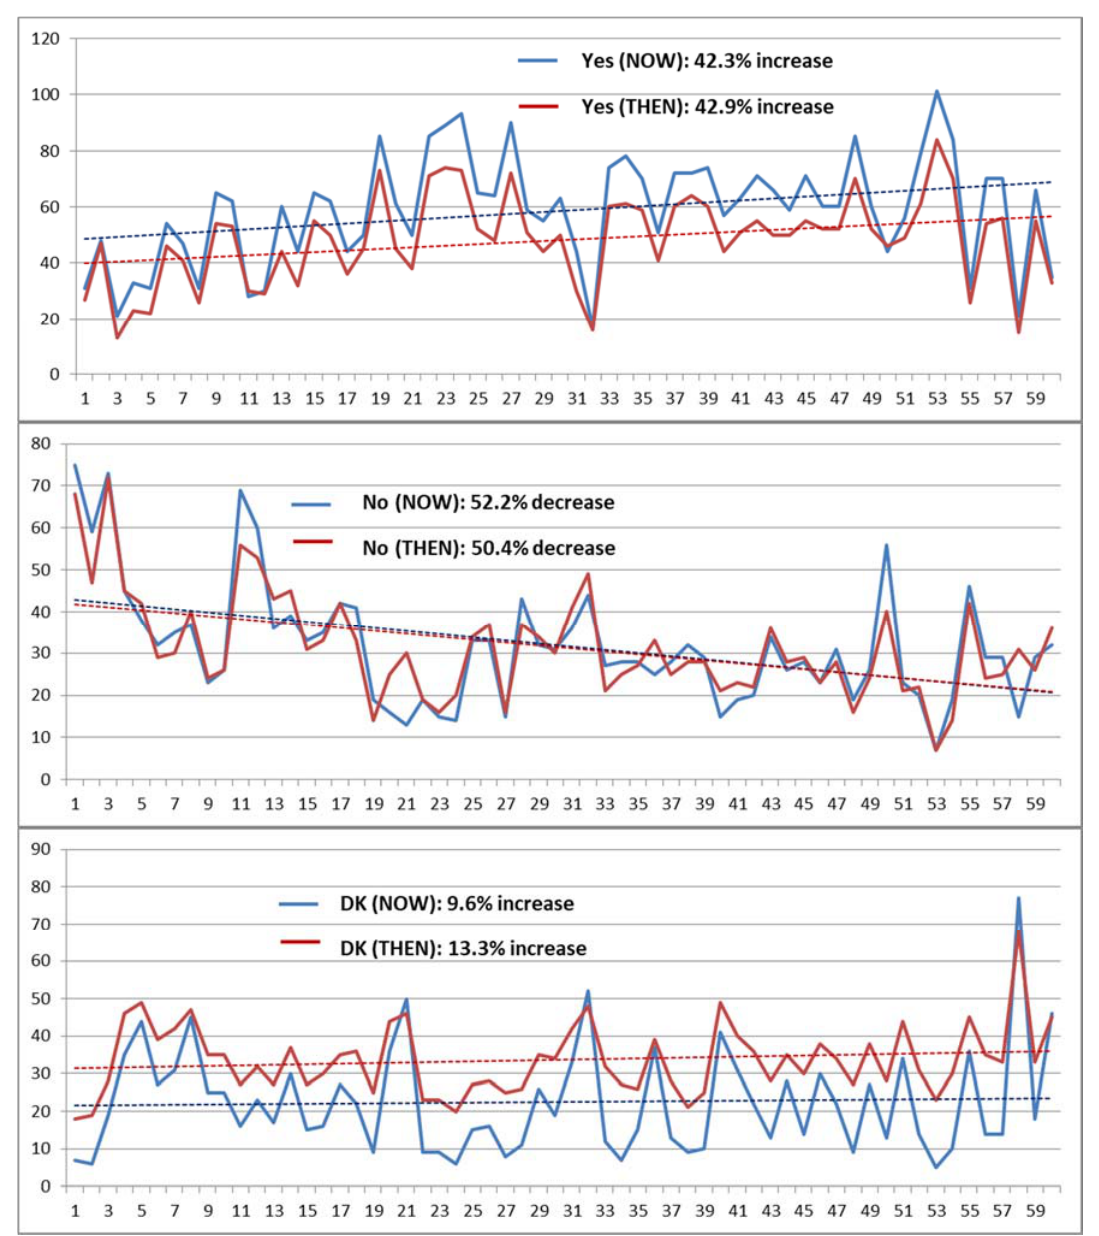
Figure 4. Changes in numbers of “Yes”, “No” and “Don’t know” responses to the 60 main questions over the course of the survey completing them.